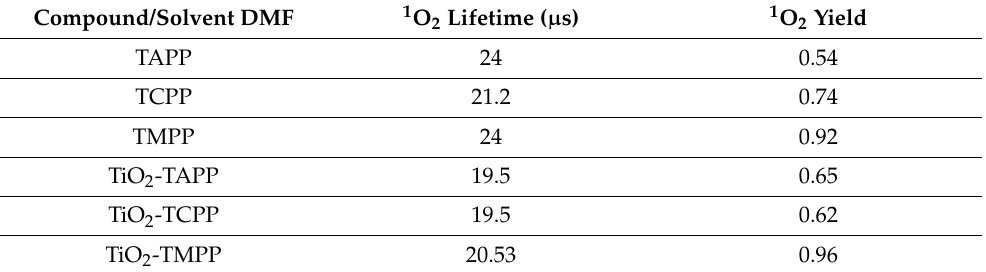
Table 6. The photophysical data on singlet oxygen generation.